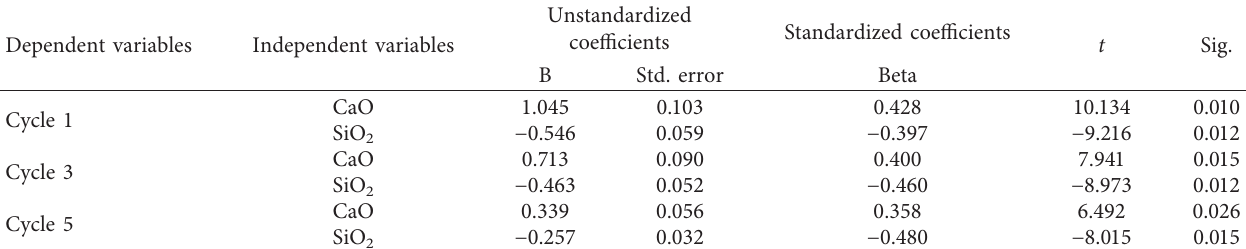
Table 10: Analysis of the effect of minerals on moisture susceptibility after 1, 3, and 5 F-T